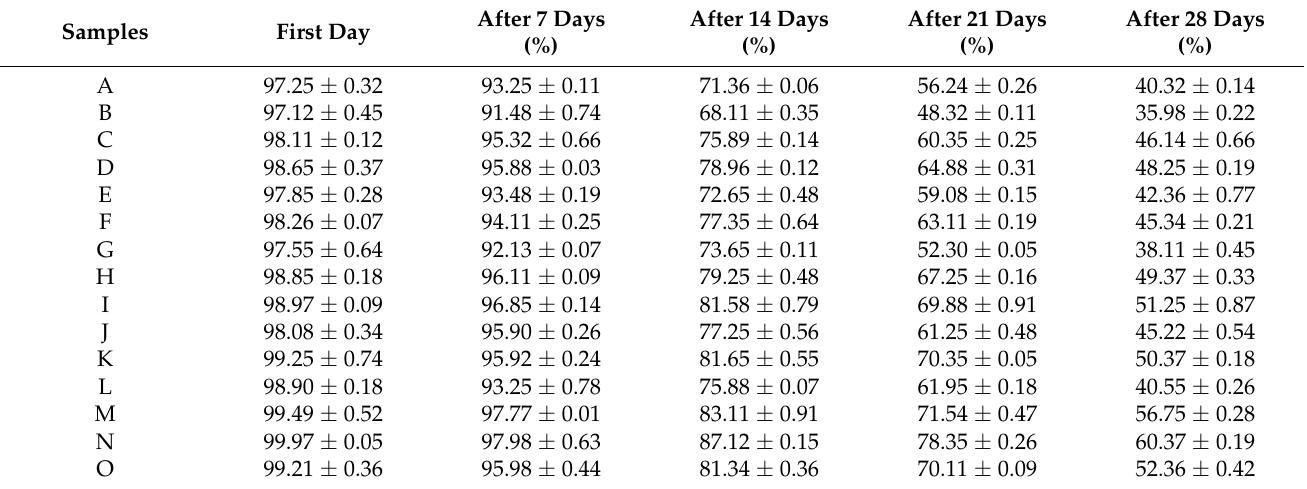
Table 6. Stability of produced